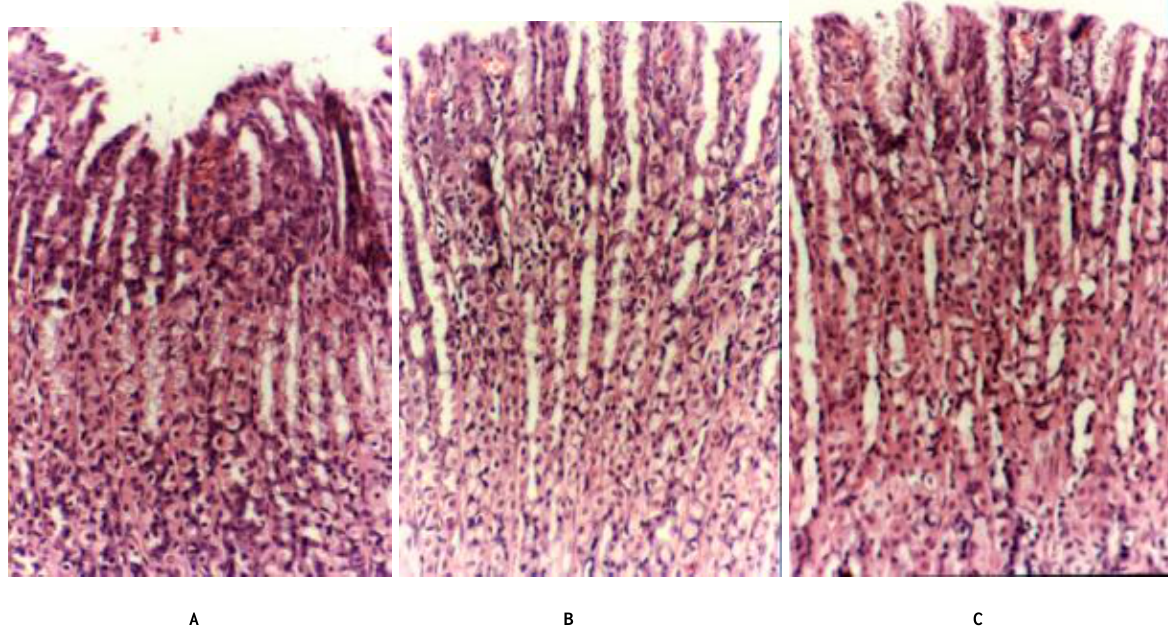
FIGURE 4 . Photomicrograph of gastric mucosa from whole-body gamma-irradiated rats subjected to pylorus ligation and 2 ml of orogastric 0.9% saline for 4 h; (A) control saline, (B) pentagstrin treated, (C) histamine treated. The mucosa shows minimal superficial injury and engorgement of microvessels with erythrocytes; changes being most marked after pentagastrin or histamine stimulation (H & E stain).